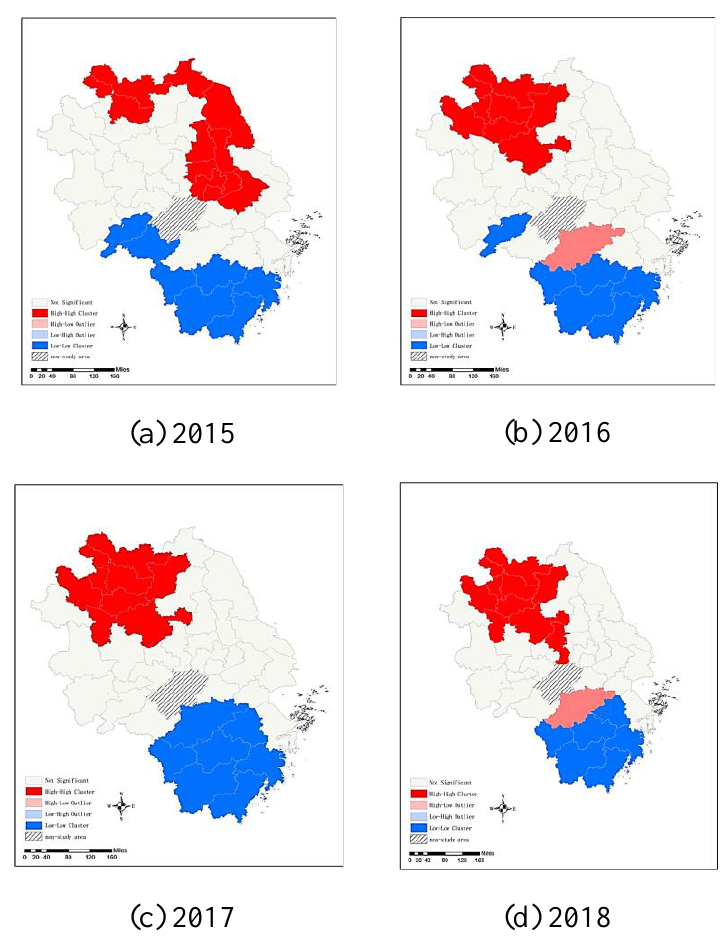
Figure 4. Types of clustering of the AQI level in the YRD from 2015 to 2018 .